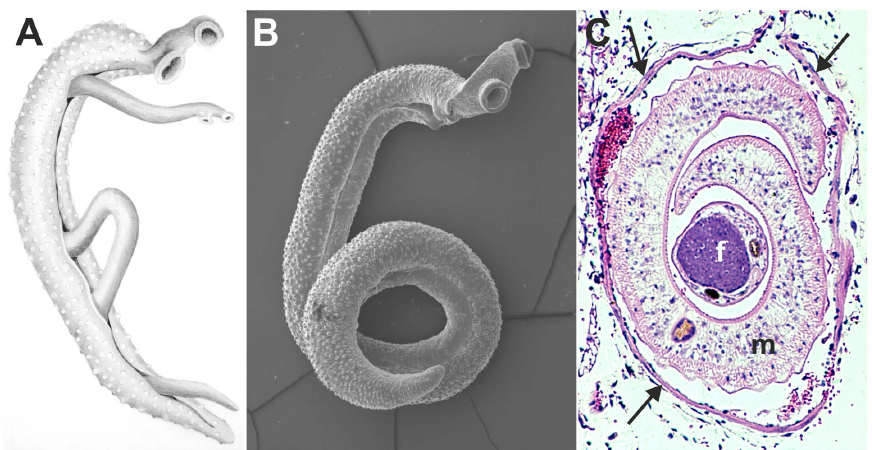
Figure 1. Images of adult schistosomes. Panel A shows a schematic drawing of an adult worm pair. The large adult male embraces the smaller female worm and both worms have two suckers by which they attach to the blood vessel wall. Panel B shows a scanning electron microscope image of a single S. mansoni adult male, which is about 1 cm long with a diameter of 1 mm. Panel C shows a cross-section of an adult S. mansoni worm pair (m, male; f, female; arrows mark the vessel wall) in a mesenteric venule of a mouse. This cross-section illustrates how close the worm pair is to the vessel wall and suggests the extent to which the worms must disturb blood flow (Panel C is adapted from D. G. Colley and W. E. Secor, PLoS Neglected Tropical Diseases 2007 [10]).